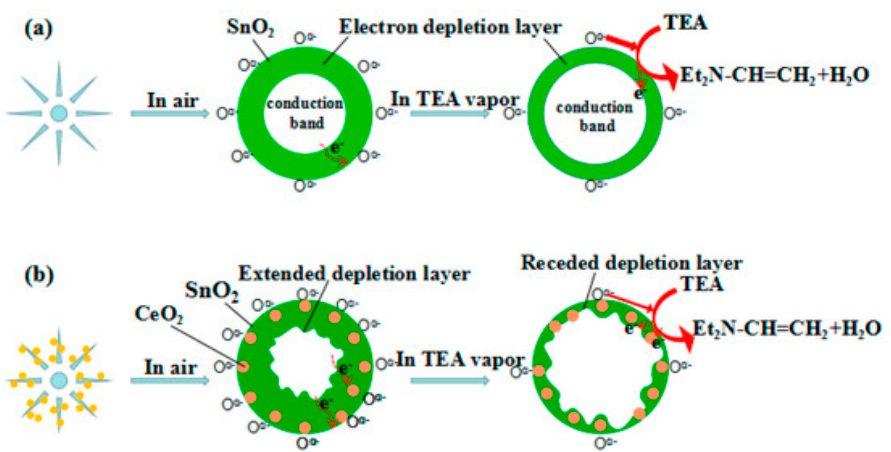
Figure 12. Sensing mechanism diagrams of ( a ) pure SnO 2 and ( b ) CeO 2 /SnO 2 nanostructures [101].